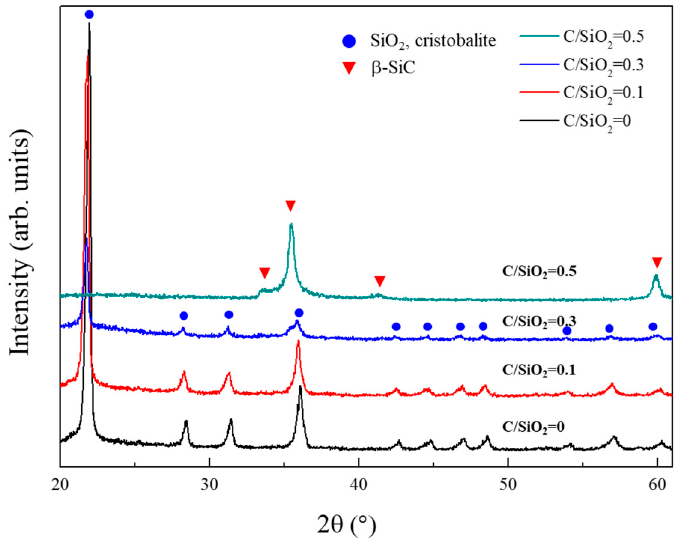
Figure 4. XRD patterns of the powder samples synthesized under various C/SiO 2 ratios at 1525 °C.